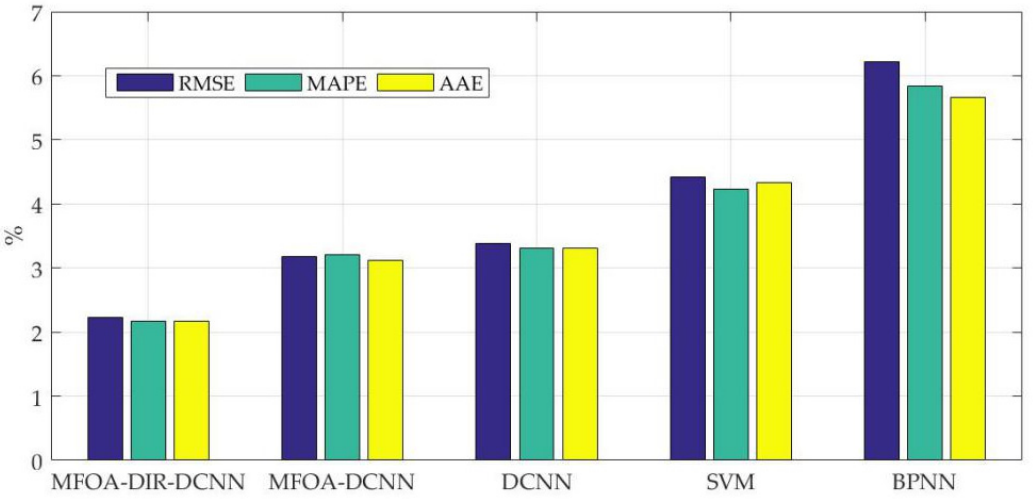
Figure 7. Root mean square error (RMSE), mean absolute percentage error (MAPE) and average absolute error (AAE) of the prediction techniques.